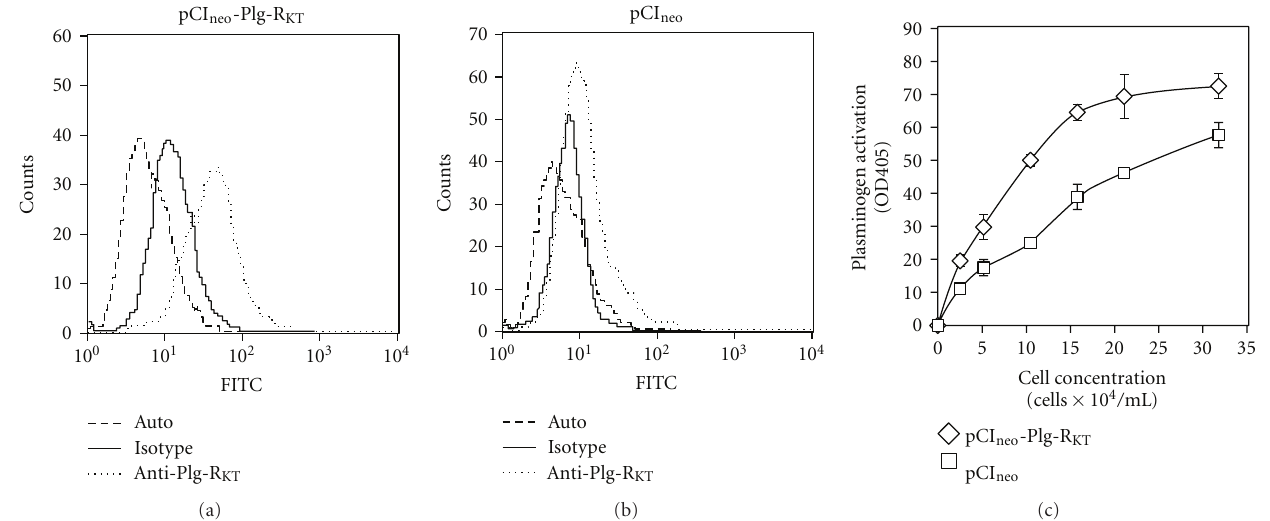
Figure 10: Overexpression of Plg-R KT increases cell surface plasminogen activation. PC12 cells stably overexpressing Plg-R KT (pCIneo-Plg- R KT ) (a) or vector alone (pCIneo) (b) were analyzed by dual color FACS analysis. Viable cells were gated from nonviable cells and histogram plots of viable cells are shown. Dotted tracings: anti-Plg-R KT mAb IgG. Black tracings: isotype control IgG. Dashed tracings: autofluorescence. (c) PC12 cells stably overexpressing Plg-R KT (pCIneo-Plg-R KT ) or vector alone (pCIneo) were incubated with plasminogen and t-PA was added and plasminogen activation was measured. Cell-mediated plasminogen activation was substantially greater in Plg-R KT overexpressing cells than in control cells ( P < 0 . 001 at each cell concentration tested) ( n = 3). [25]. ©The American Society for Biochemistry and Molecular